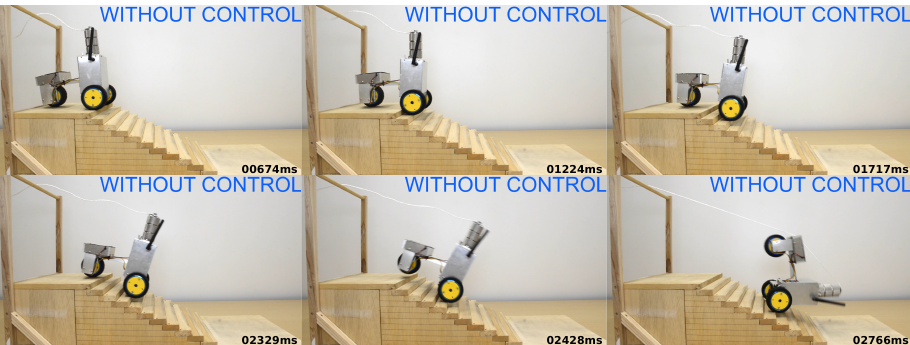
Figure 20. Prototype descending without control (time stamps in milliseconds are roughly estimated from the videos).